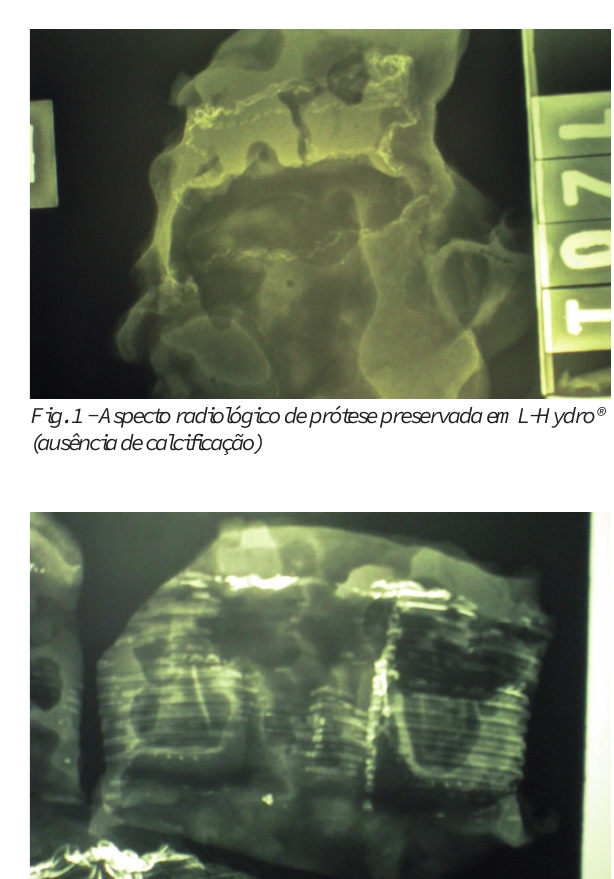
Fig. 2 - Aspecto radiológico de prótese preservada em glutaraldeído (calcificação